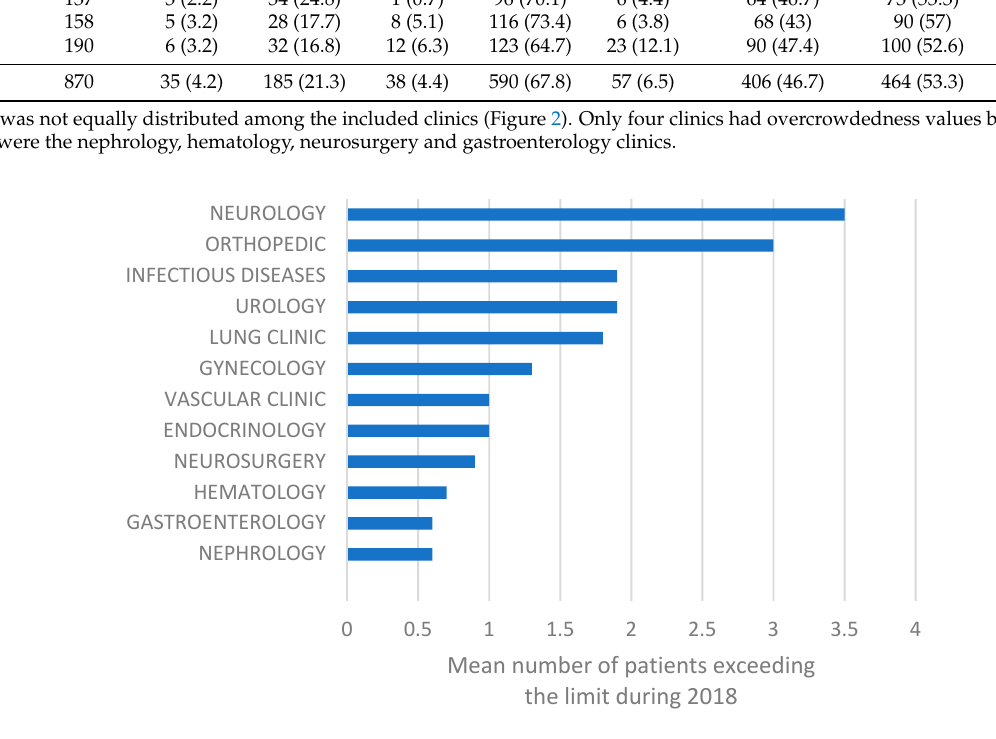
Figure 2. Meanvalueofpatientovercrowdednessatthedifferentclinics. Avalueof ≥ Figure 2. Mean value of patient overcrowdedness at the different clinics. A value of ≥ 1 indicates overcrowdedness.